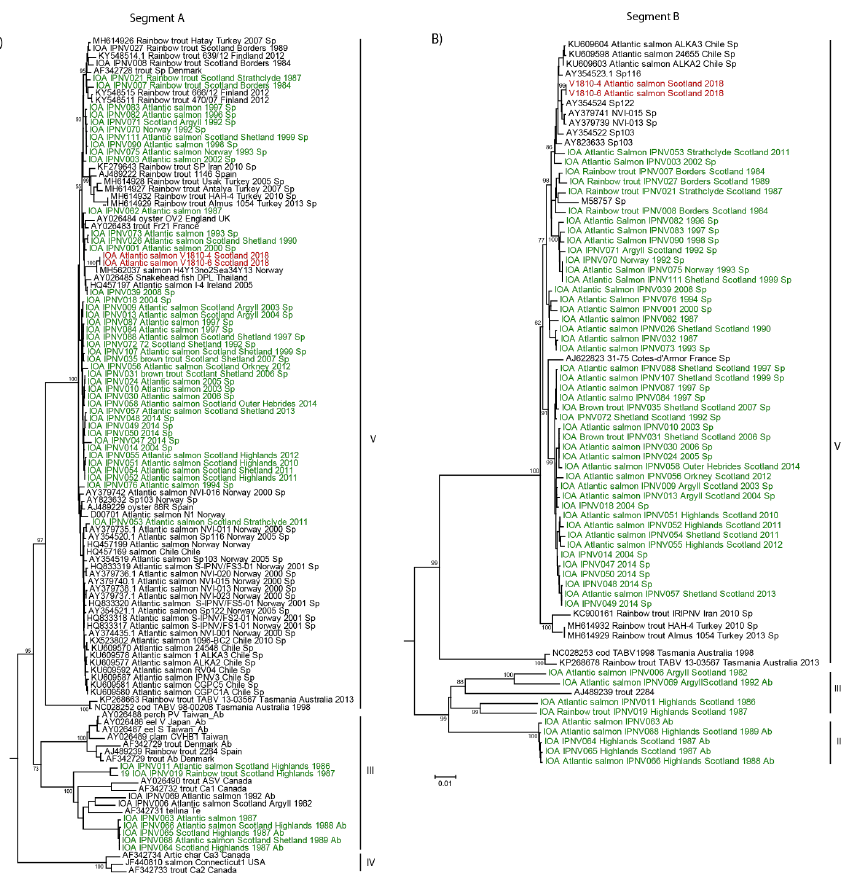
Figure 1. Phylogeny of the new Scottish infectious pancreatic necrosis virus (IPNV) isolates V1810. Nucleotide sequences of the new isolates from Scotland, V1810–4 and V1810–6, were aligned with previous Scottish isolates and similar sequences retrieved by BLAST on NCBI. The alignment was conducted by MUSCLE implemented in MEGA 6. The phylogenetic tree was inferred in MEGA6 with the neighbor-joining method. Bootstrap percentages >70 are indicated. ( A ) Phylogenetic tree of IPNV segment A. ( B ) Phylogenetic tree of IPNV segment B. Sequences on the trees colored in red correspond to the new Scottish isolates V1810–4 and V1810–6; in green are previous Scottish isolates, and in black are sequences retrieved by BLAST on NCBI.